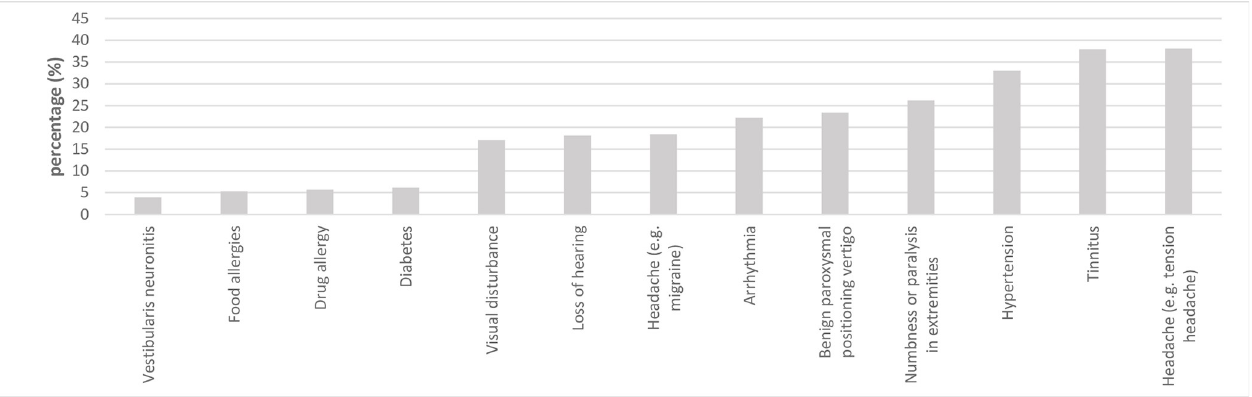
Fig 1. Proportion of participants that had experienced specific health conditions.